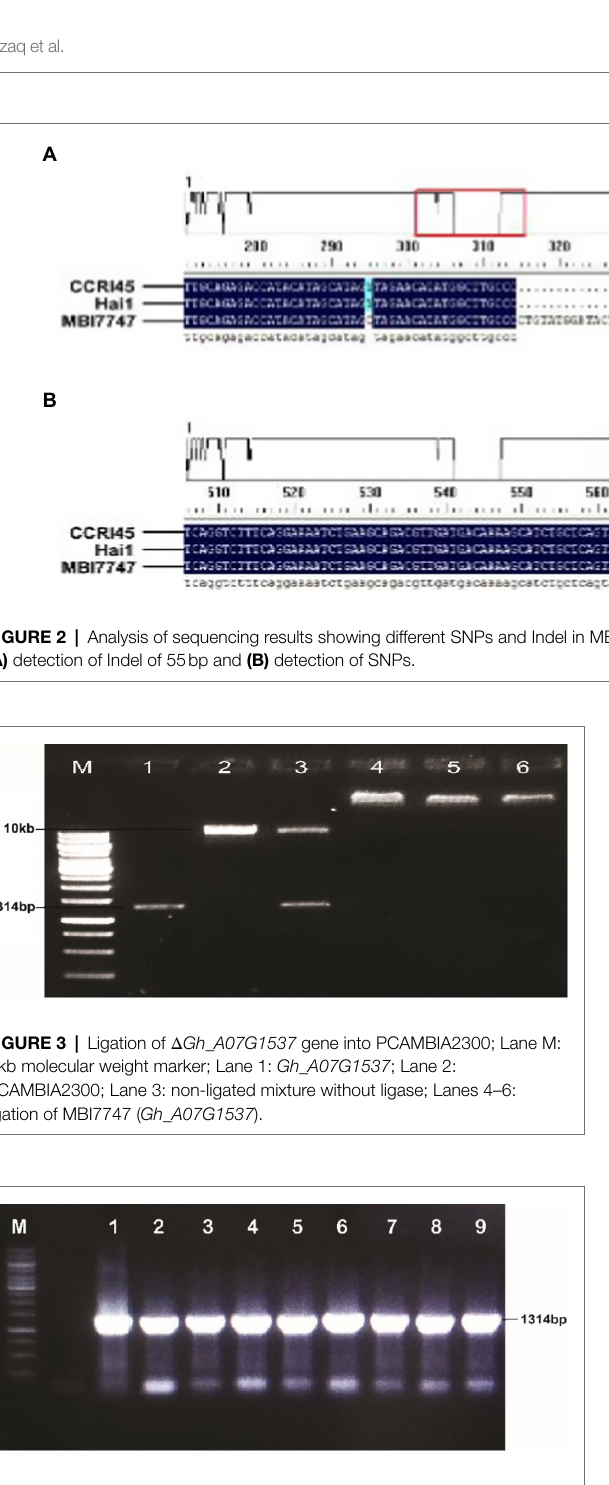
FIGURE 4 | Confirmation of recombinant Agrobacterium tumefaciens through PCR (Full length primers); Lane M: 1 kb molecular weight marker; Lanes 1–9: MBI7747 ( Gh_A07G1537